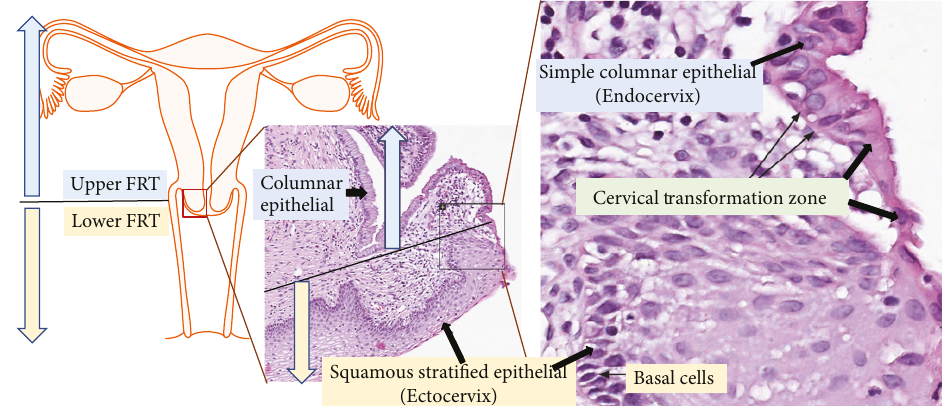
Figure 1: Histology of the female reproductive tract (FRT). This fi gure illustrates the two immunologically distinct regions of FRT (see left side), i.e., the pathogen-laden lower FRT, shown by the yellow arrow, and the “ sterile ” upper FRT (see blue arrow) and their respective histological sections (see images in the middle and right side). Image credit of histological section: Human Protein Atlas, available from http://v18.1.proteinatlas.org.